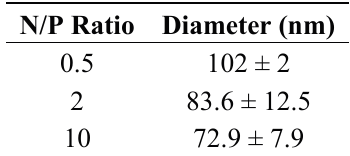
Table 1. Sizes of protamine/DNA complexes.